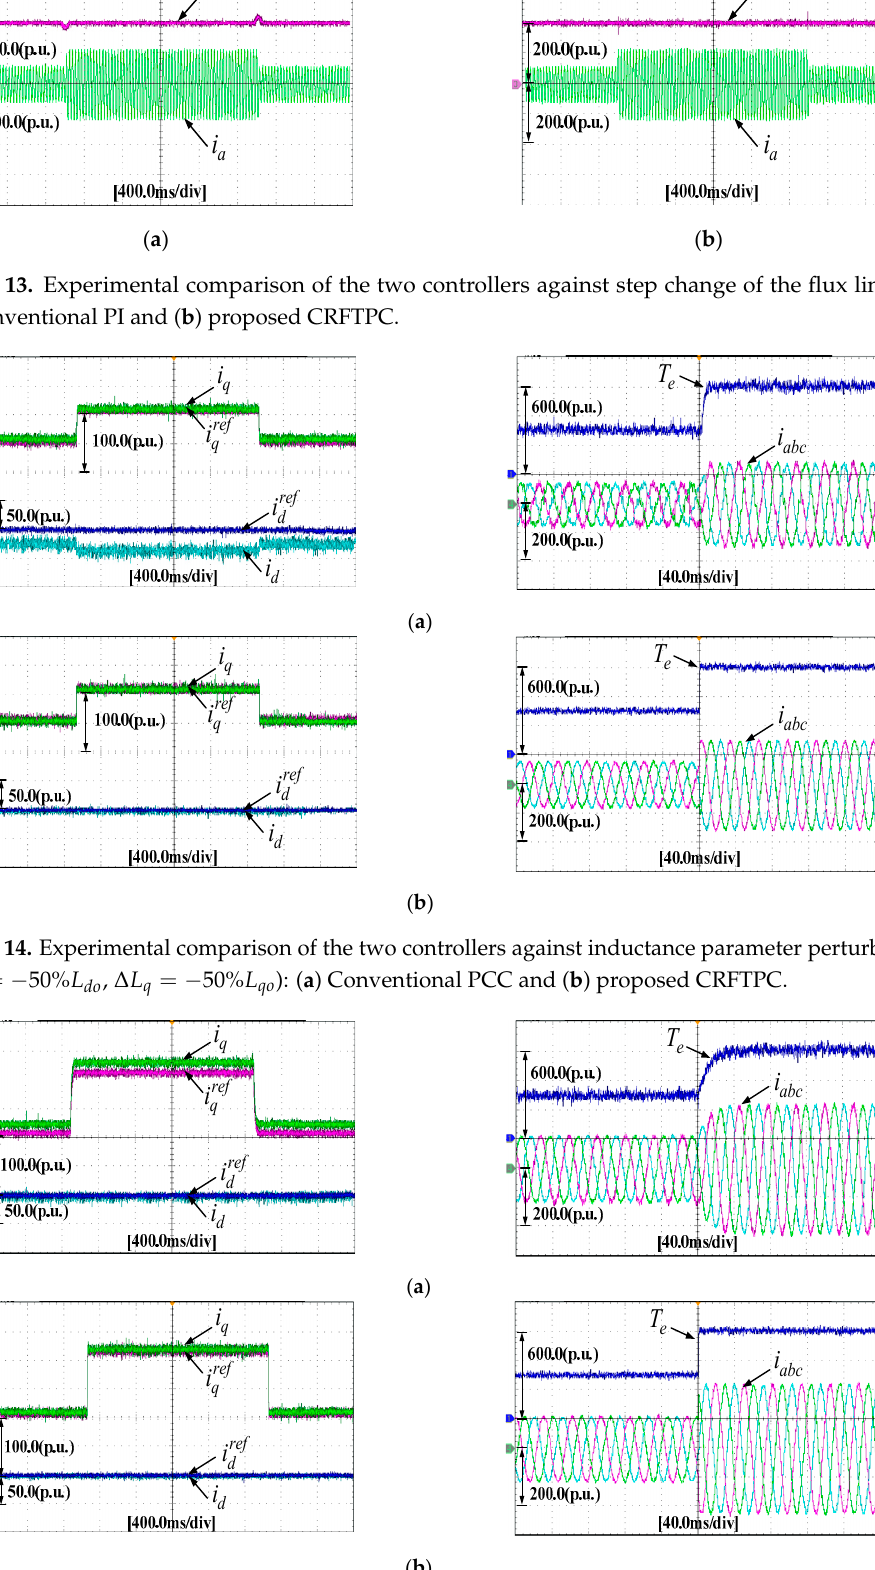
Figure 15. Experimental comparison of the two controllers against permanent magnet demagnetization 50% rd ro Δ =− （ ） ψ ψ : ( a ) Conventional PCC and ( b ) proposed CRFTPC.